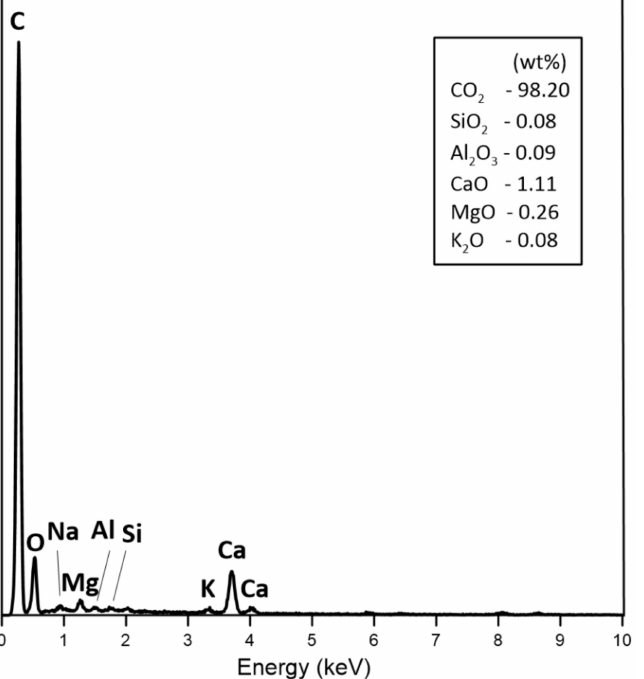
Figure 4. An analysis of the elemental composition of micro-samples of dry residue cavitated charcoal using EDS